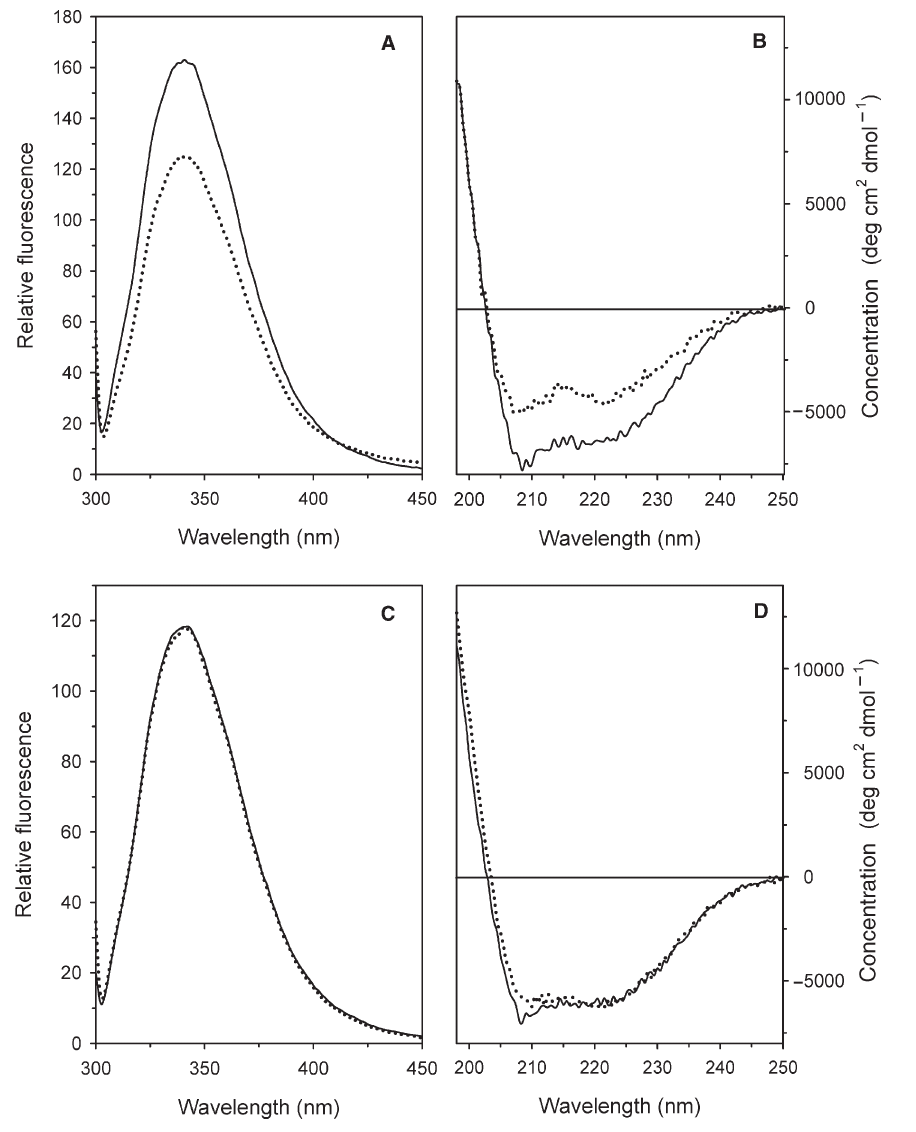
Figure 3. Effects of pH on the intrinsic fluorescence and on far UV CD spectra of the Solfolobus solfataricus recom- binant wild type (wt) amidase and the Y41C mutant. Fluores- cence emission spectra (A, C) were recorded with the excita- tion wavelength at 295 nm. Far UV CD spectra were recorded in a 0.1 cm path-length quartz cuvette. All spectra were re- corded with 0.1 mg ml –1 pro- tein concentrations at 20 °C after overnight incubation of the wt (A, B) and the Y41C mutant (C, D) at pH 8.0 (20 mM sodium phosphate, solid line) and pH 5.0 (20 mM sodium citrate, dotted